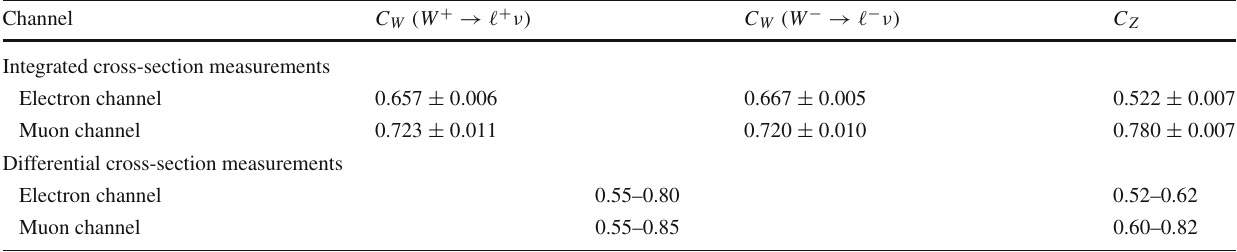
Table 2 Correction factors C W [ Z ] used to calculate integrated and dif- ferential W and Z boson production cross sections. The integrated C W [ Z ] factors are shown with the sum in quadrature of statistical and